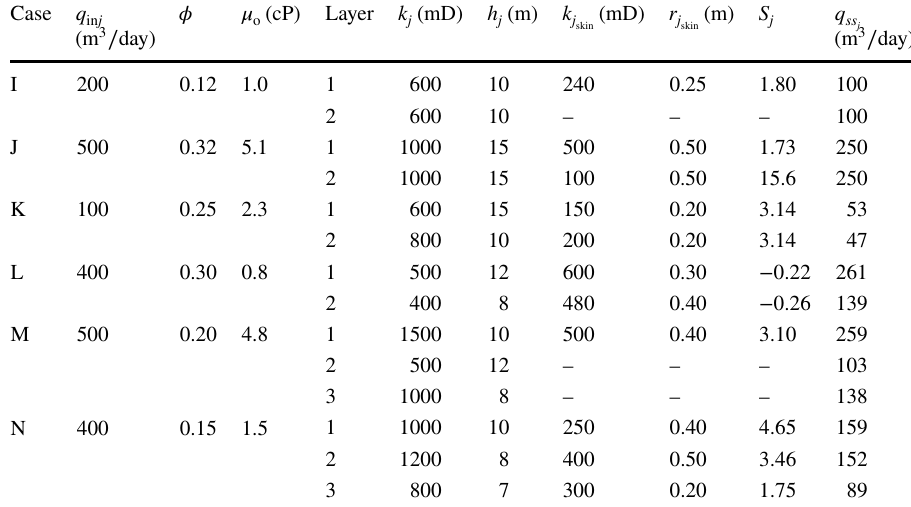
Table 3 Multilayer cases